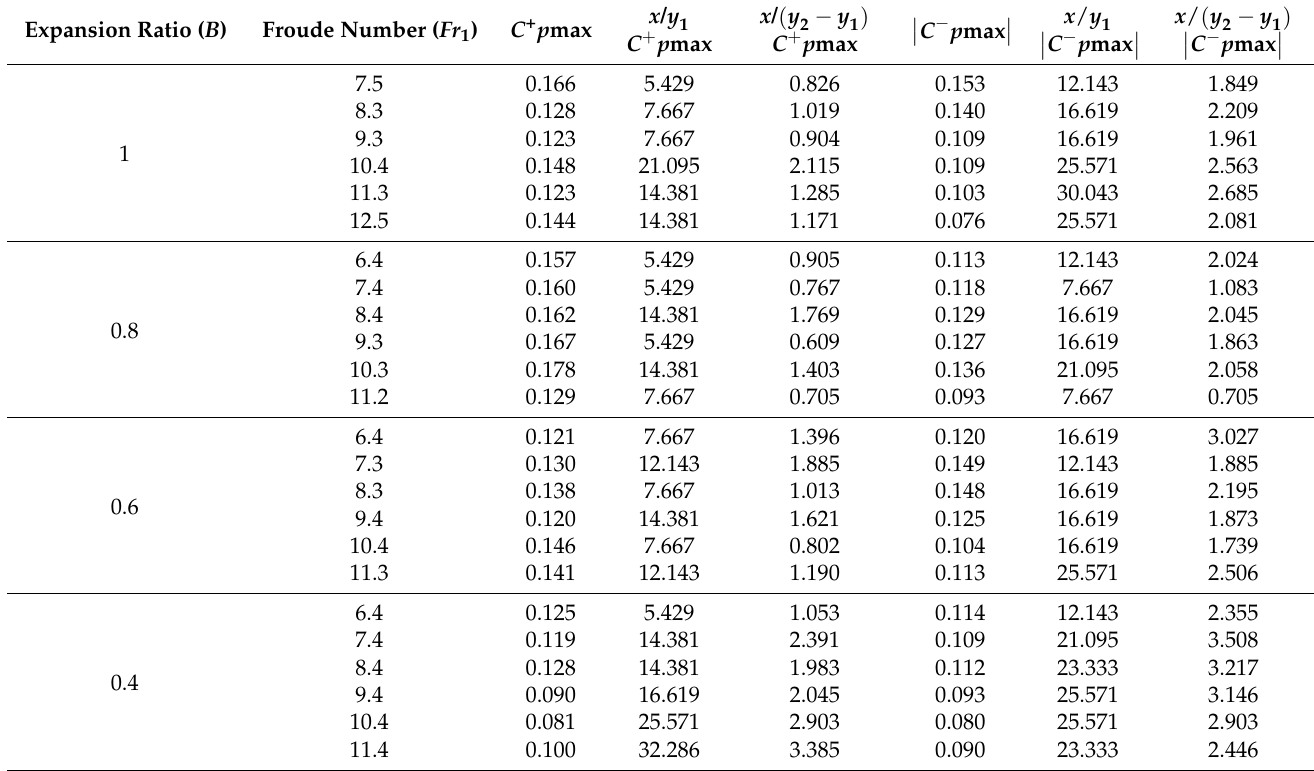
Table 3. Variation of maximum positive and negative pressure